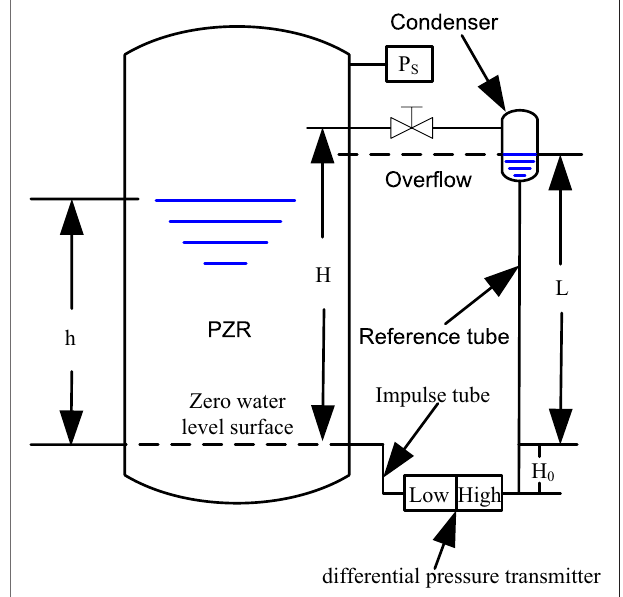
FIGURE 2 | Outside vessel single-reference-tube water level